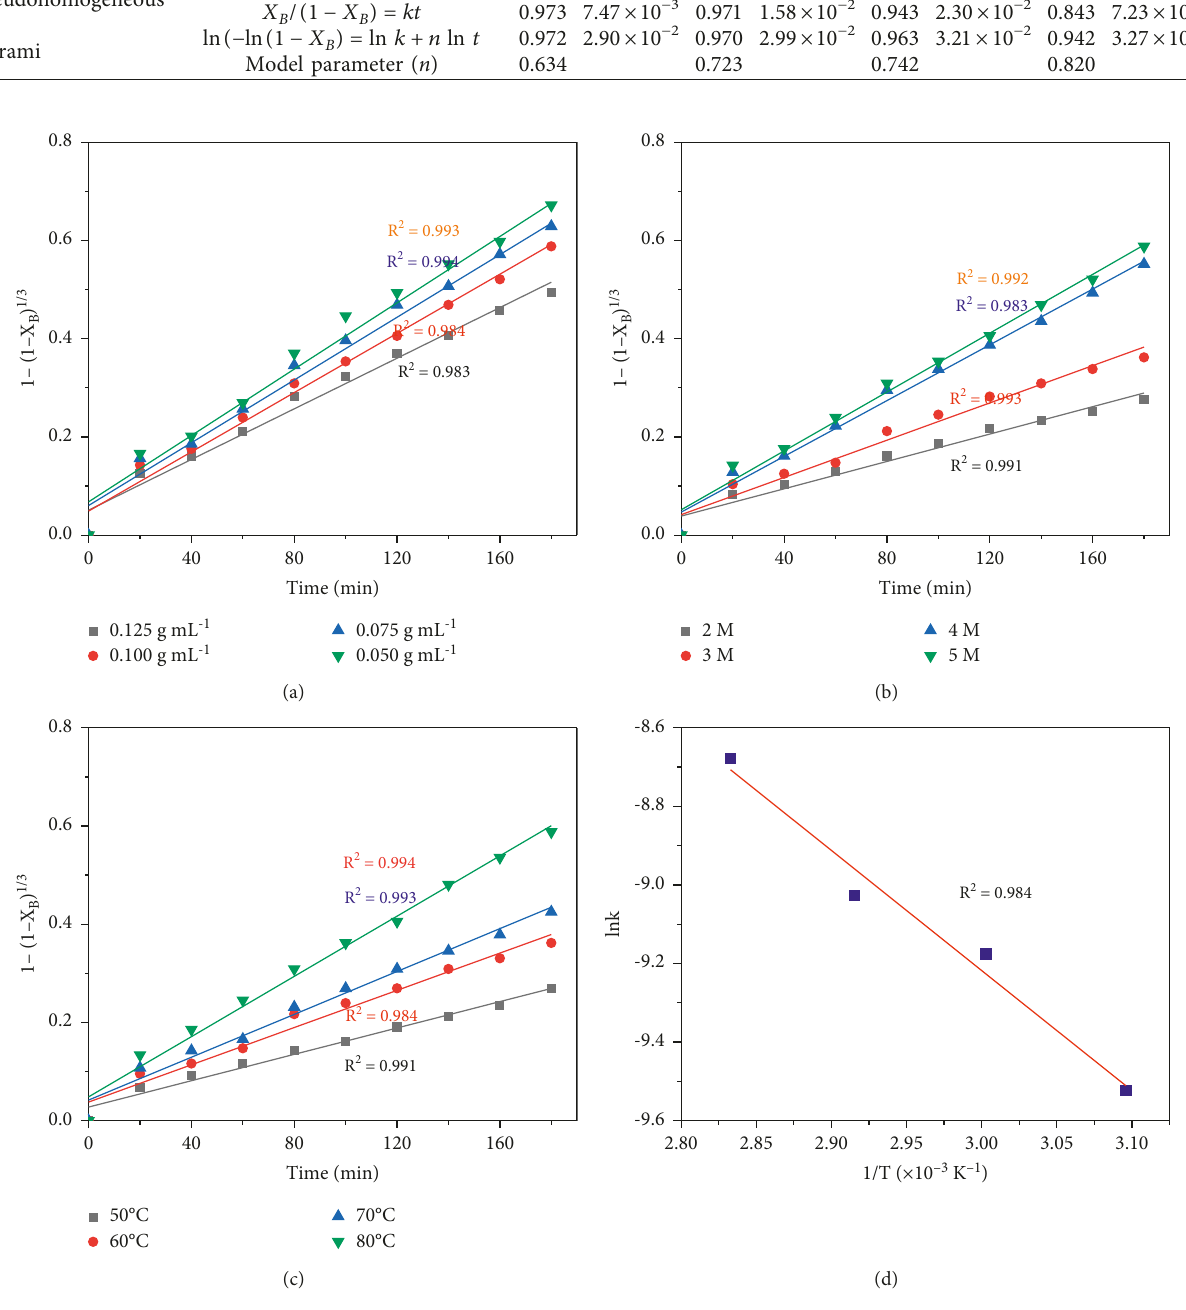
Figure 3: The regression plots of first-order reaction kinetics of shrinking core model at various (a) solid-to-liquid ratios from 0.05 to 0.125g · mL − 1 , (b) acid concentrations from 2 to 5M, and (c) reaction temperatures from 50 to 80 ° C; (d) the Arrhenius plot of the first-order chemical